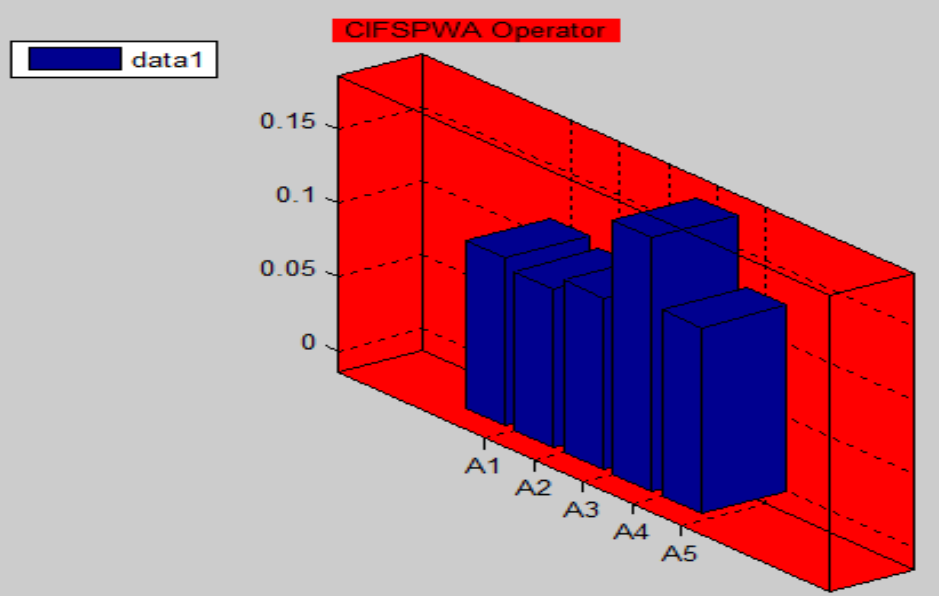
Figure 2. Graphical expressions of the information in Table 6. The IFSSs sorts of information are discussed in Tables 7–10. Table 7. Original decision matrix for candidates (cid:101) Ξ CI − 1